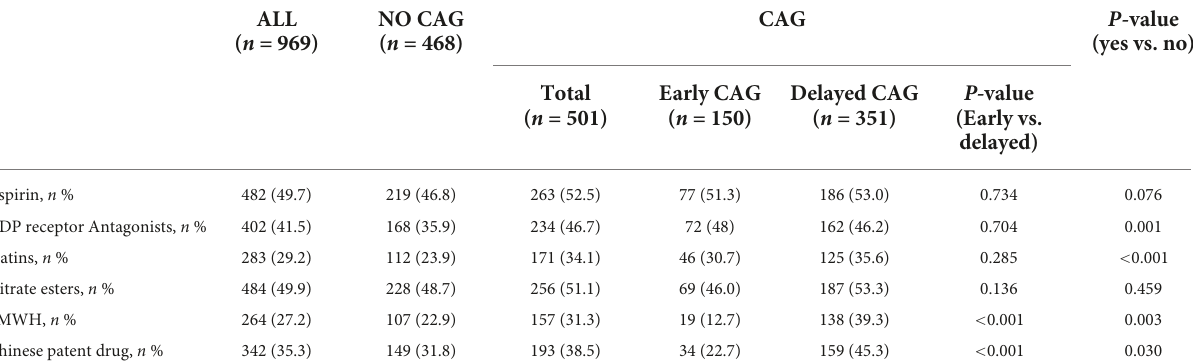
TABLE 2 Emergency medication for NSTEMI patients in the EDs.